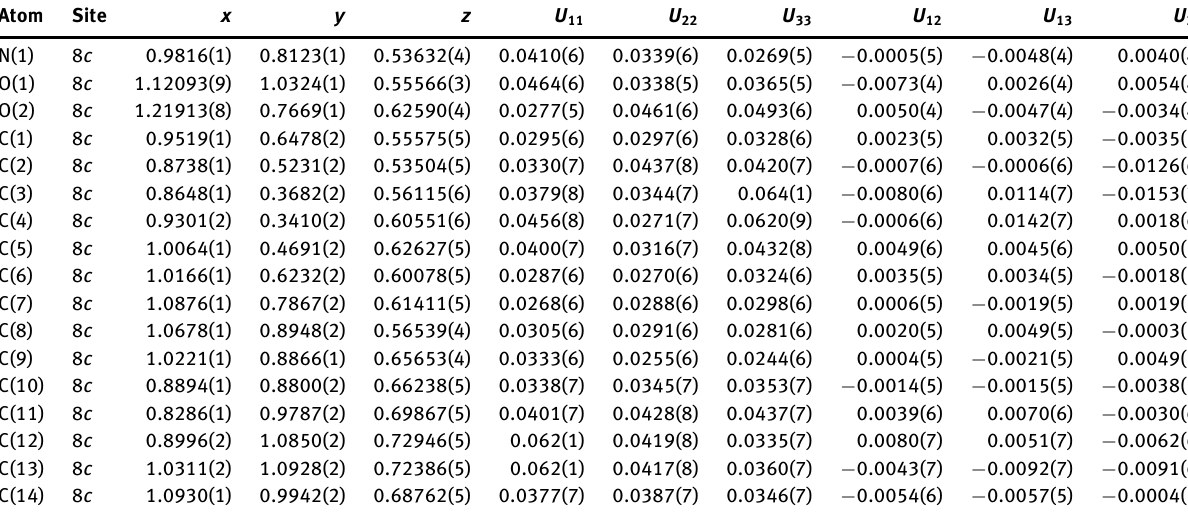
Table 3: Fractional coordinates and atomic displacement parameters (Å 2